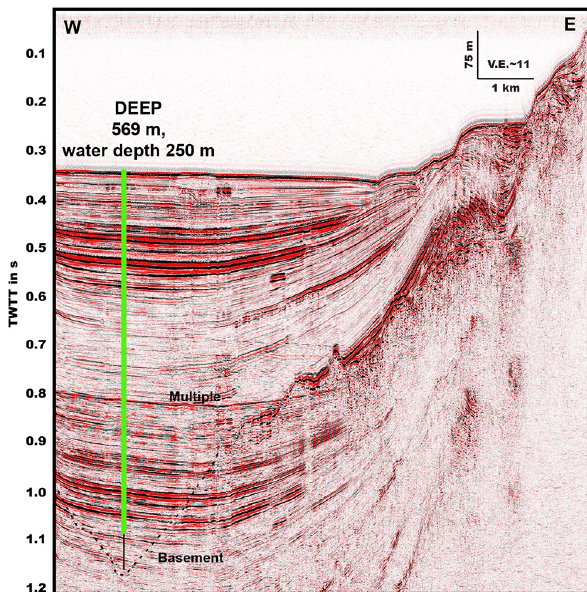
Figure 3. Seismic profile crossing the DEEP site in W–E direc- tion (only Macedonian part of Lake Ohrid due to missing Albanian permissions during the 2007 survey). See Fig. 1 for location. The green line in the seismic profile indicates the approximate maxi- mum depth of cores recovered from DEEP site, whilst the black line indicates the originally proposed target